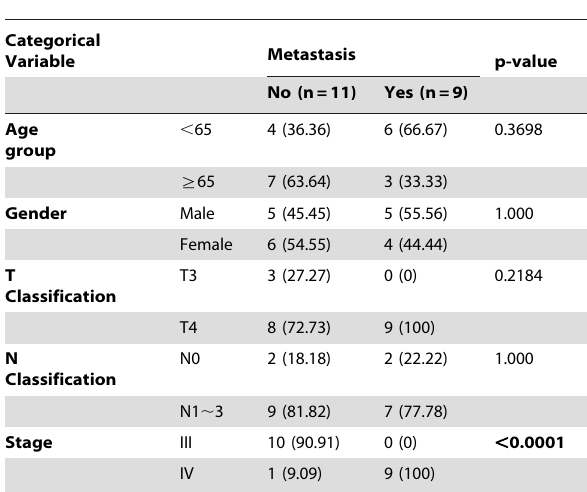
Table 4. Univariate analysis for correlation between metastasis and clinico-pathological variables in 20 patients with MPE.